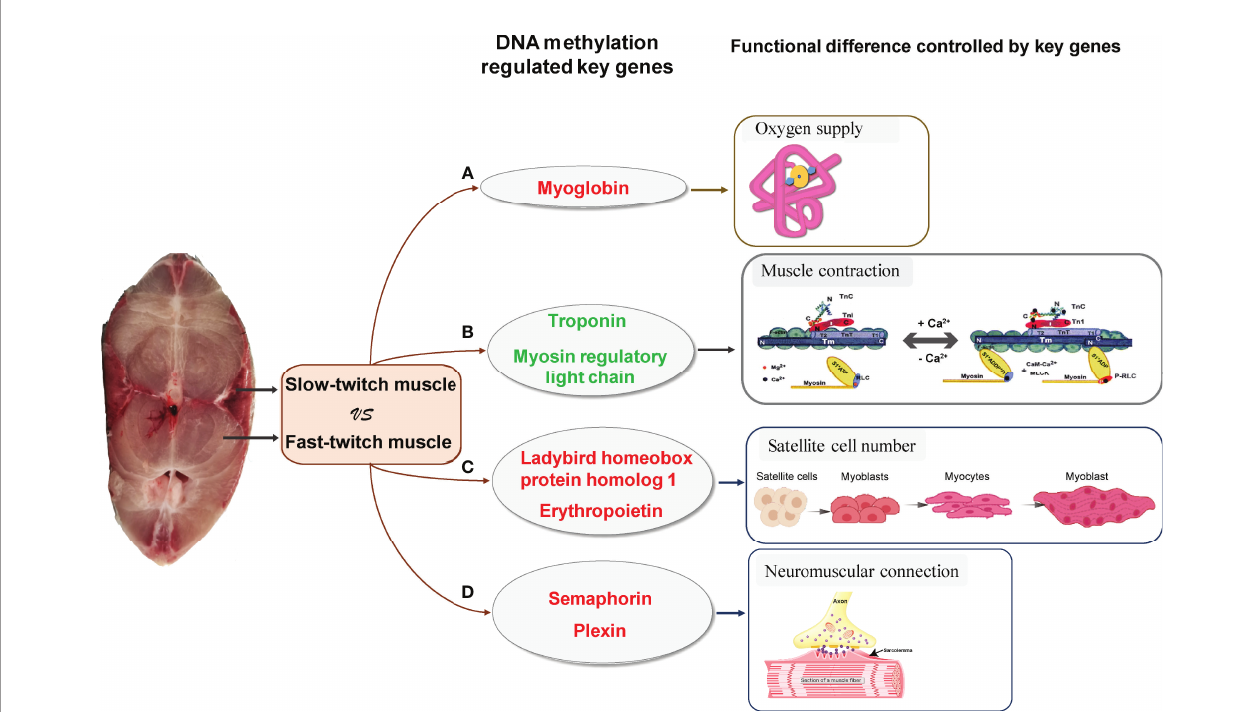
FIGURE 5 | Critical methylated genes associated with phenotypic differences between slow- and fast-twitch muscles of P. dentex . (A) Hypomethylated and highly expressed myg in SM (red letter) indicated demethylation of the myg promoter could upregulate its expression, thus increasing O 2 supplying and meeting the oxygen demands of SM. (B) Hypermethylated and lowly expressed tnn and rlc (green letter) in SM may be associated with low mobility of myosin cross bridges, which lead to slower and less frequent muscle contraction in SM than in FM. (C) Hypomethylated and highly expressed lbx1 and epo genes (red letter) may be related to increased satellite cell numbers, and Semaphorin/Plexin genes (red letter) (D) may be related to higher rate of neuromuscular connection reconstruction, which further promote high muscle regeneration ef fi ciency in SM. The schematic diagram of gene physiological function mainly referred to Jahan (Jahan) and Szczesna (Szczesna, 2003) and was slightly modi fi